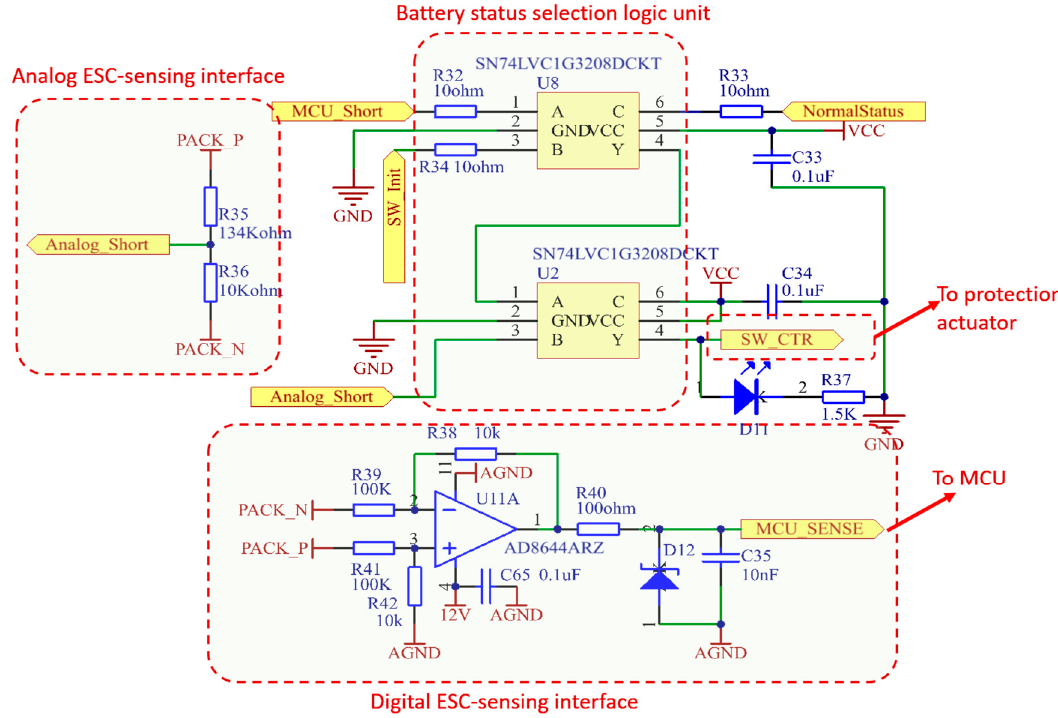
Figure 4. Dual-protection hardware design for external short-circuit (ESC) to microcontroller (MCU).